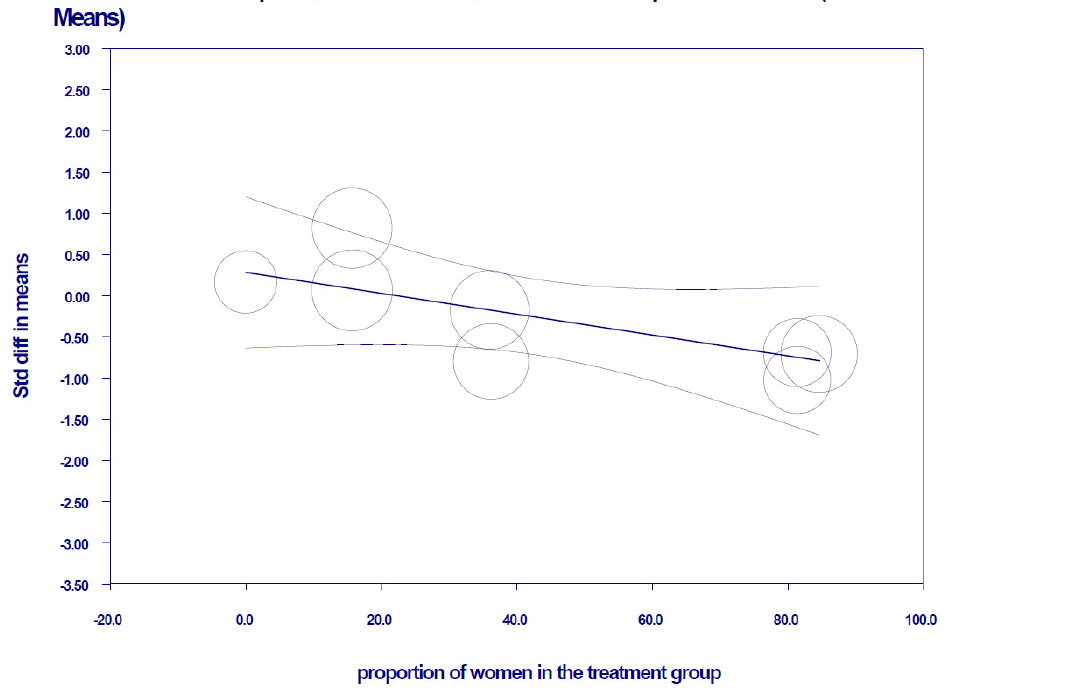
Figure 6. Linear relationship with 95% confidence intervals between the moderating variable “percentage of women” in the meta-analysis studies and the standardized observed mean effect size of TG (mixed-effects). A decrease in TG is observed in studies with a higher percentage of women.